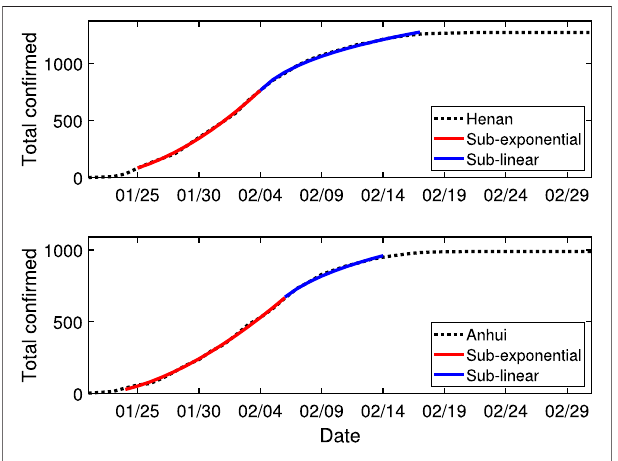
FIGURE 1 | The fi tting results of Henan and Anhui provinces in China. The black dashed curves represent the real data. The red and blue segments represent the sub-exponential and sub-linear growth of the total con fi rmed casesovertime.Theparametersanddatesinconsiderationsfordifferent cases are listed in Table 1